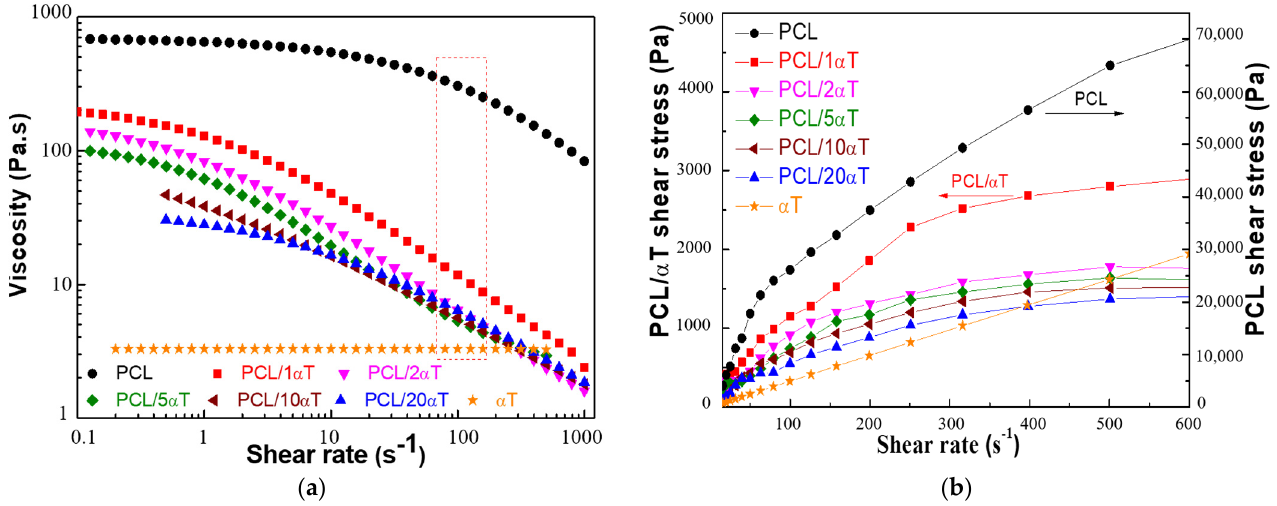
Figure 1. Viscosity ( a ) and shear stress ( b ) as function of shear rate for the PCL solutions containing α -tocopherol.